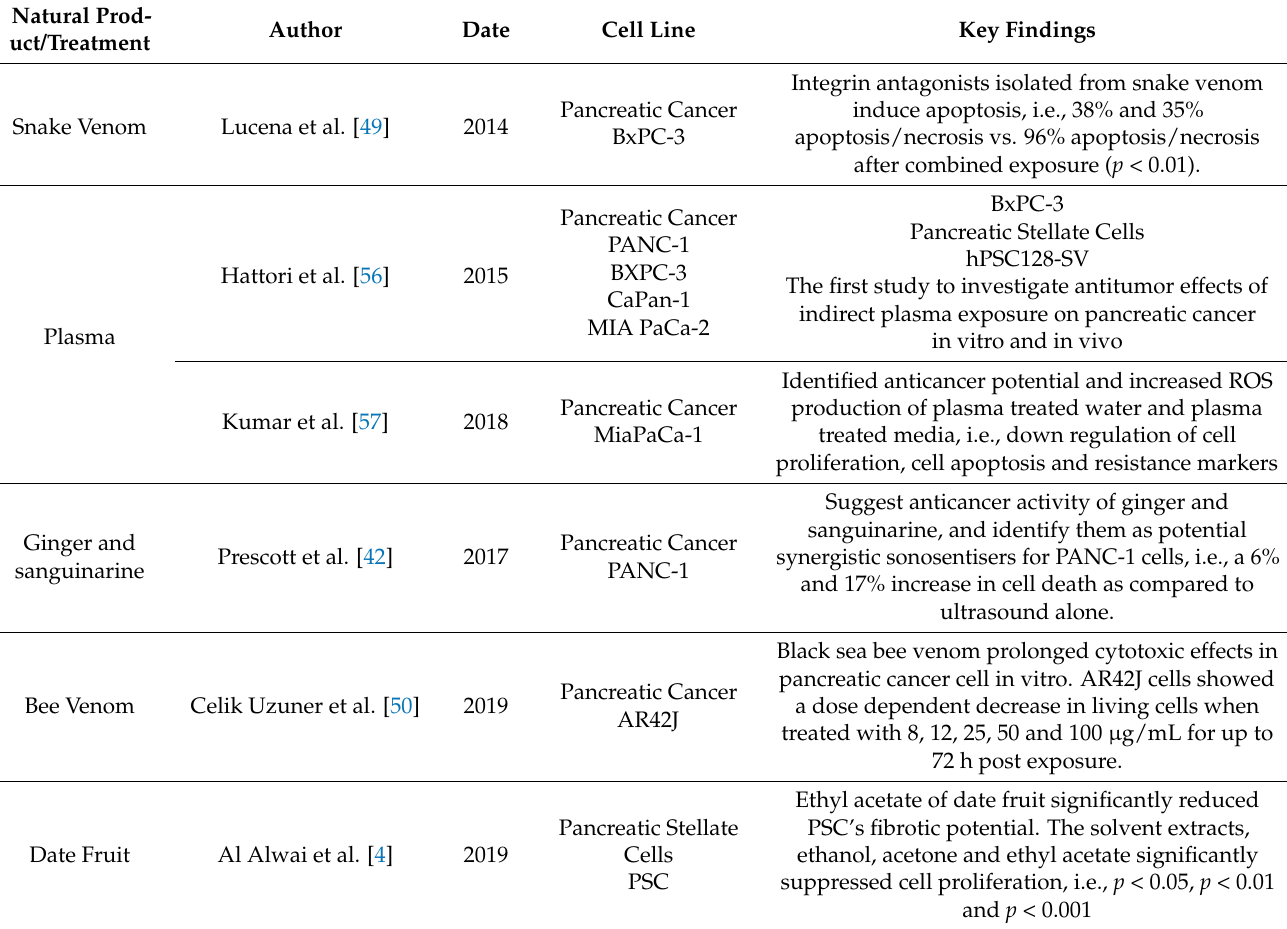
Table 1. Novel and natural anti-cancer targeting compounds for